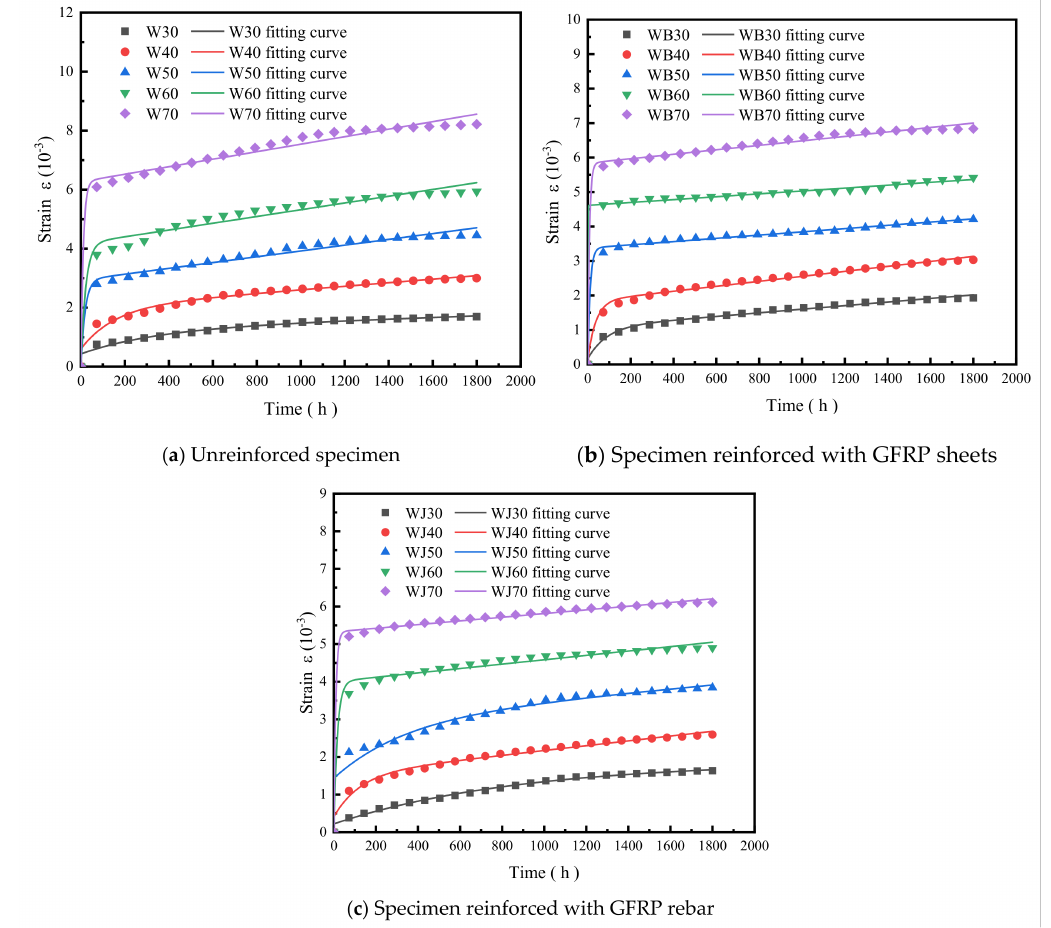
Figure 10. Fitting curve of four-element model of PVC-based